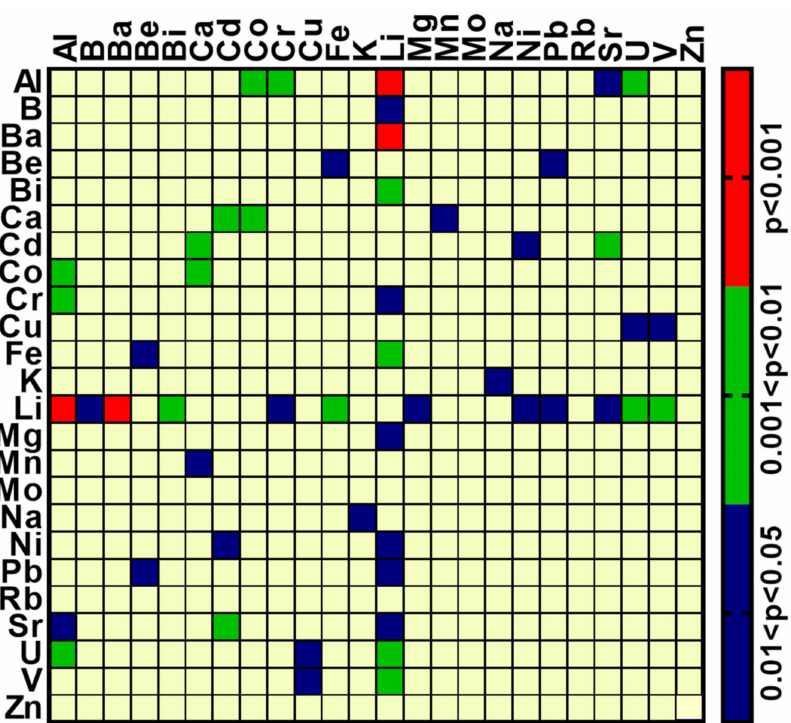
Figure 2. Heat map of the comparison of Spearman correlation coefficients (rs) of element concentra- tions between control and BD patients. The rs were computed for all pairwise comparisons, separately for the control and the BD patients. The two-tail significance of the difference between the rs of the control and BD groups for each pair of elements was tested, as described in the results section; only those elements statistically different are shown, grouped according to the scale to the